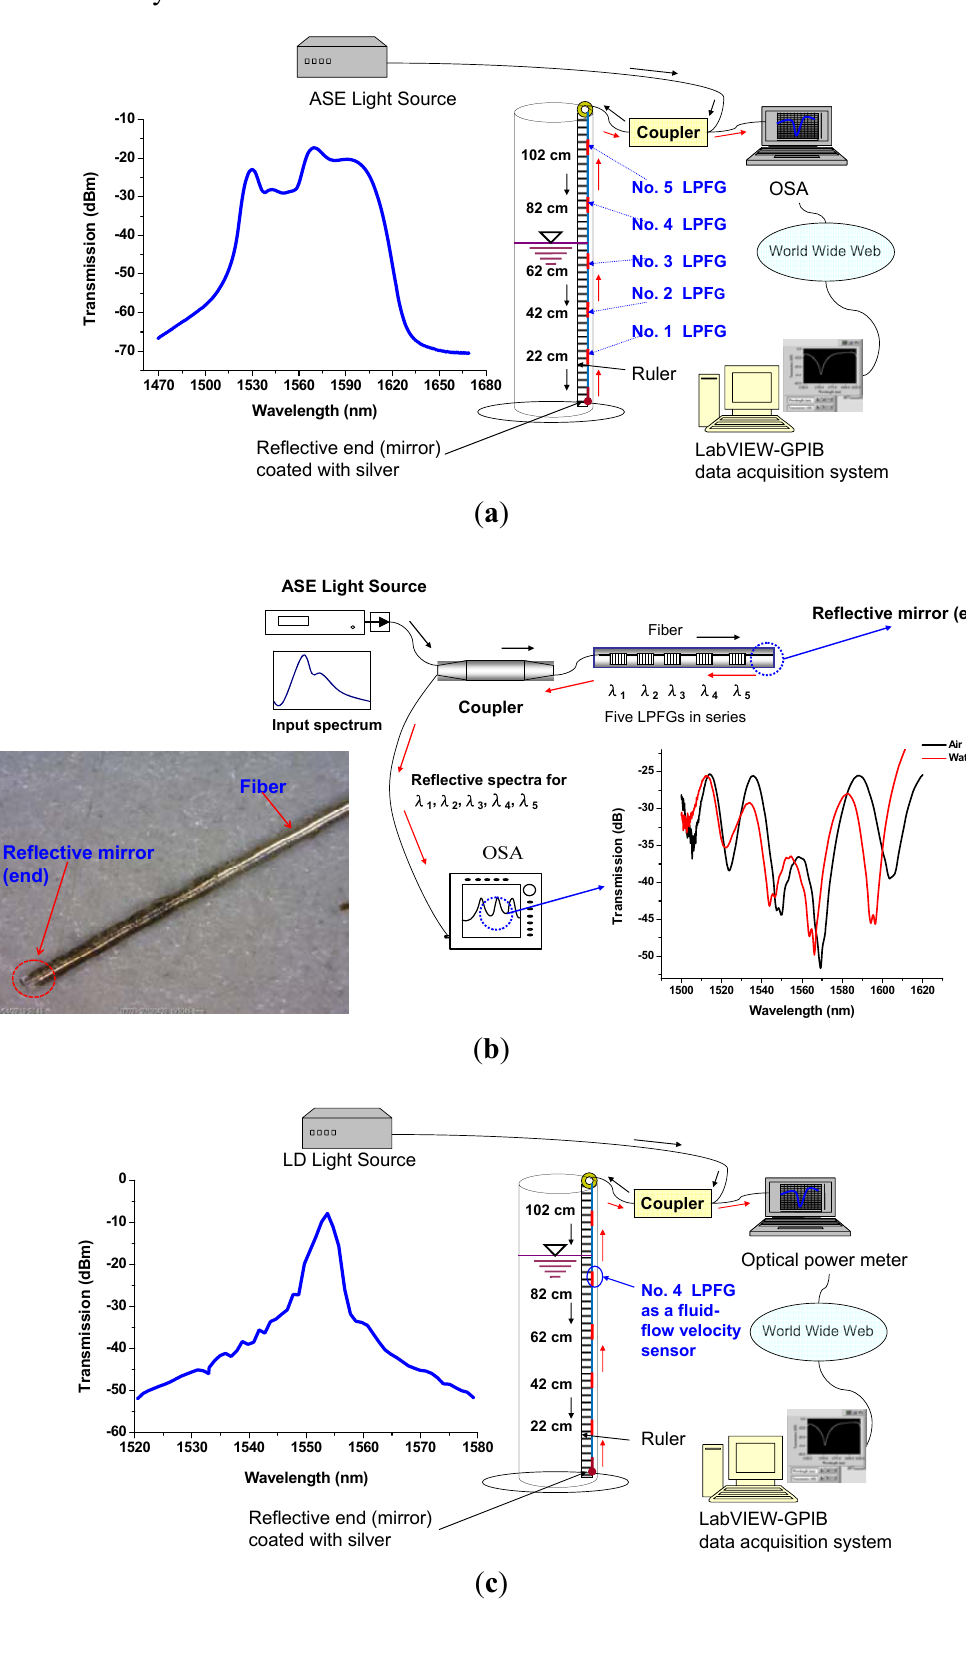
Figure 3. ( a ) Experimental setup for the reflective LPFGs-in-series liquid level sensor; ( b ) Schematic and photo about the reflective mode for five LPFGs in series as a result of a reflective coating at the tip of the SMF-28 fiber; ( c ) Experimental setup for the reflective fluid-flow velocity